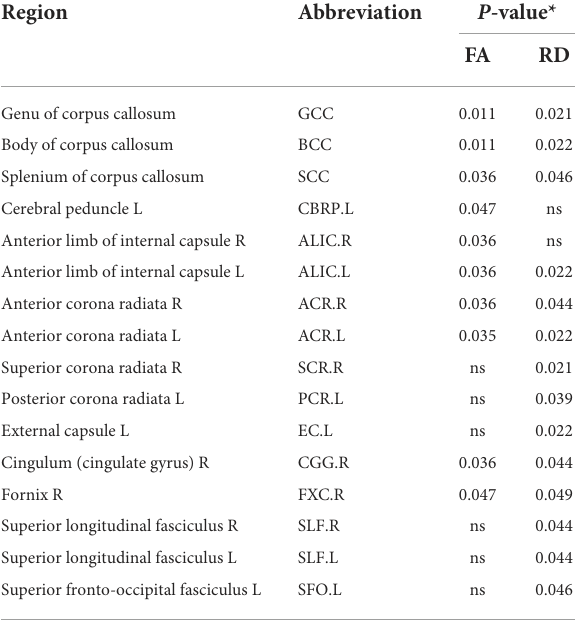
TABLE 3 Regions with a significant between-group difference by atlas-based analysis.